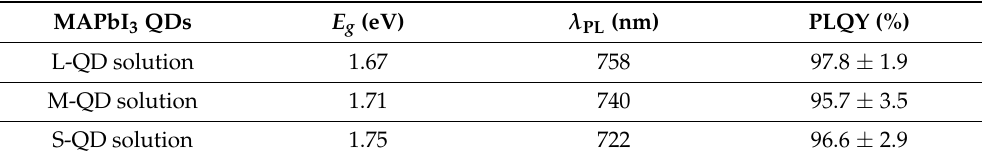
Figure 3. ( a ) X-ray diffraction patterns of various sizes of MAPbI 3 QDs. ( b ) Normalized UV-visible absorption and steady-state photoluminescence spectra of various sizes of MAPbI 3 QDs. ( c ) Tauc plot of the optical band gap energy for various size of MAPbI 3 QDs calculated by extrapolation of the linear part of ( α hv ) 2 versus ( hv ). ( d ) The evolution of PLQY for various size of MAPbI 3 QD colloidal solution saved in ambient conditions. Table 1. The determined band gap, PL peak position and corresponding PLQY of three-sized MAPbI 3 QDs.